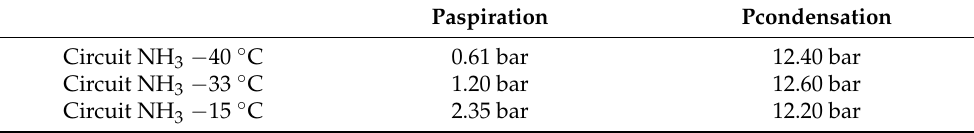
Table 2. Average operating pressure values of the refrigeration circuits.